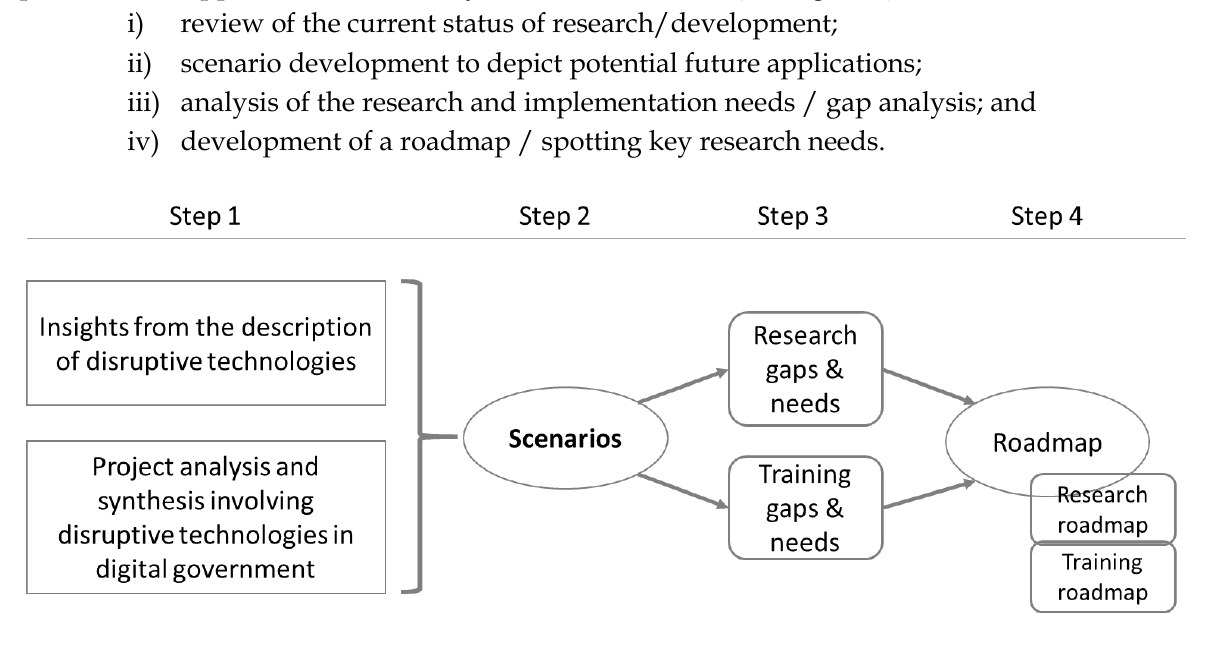
Figure 1: Research design to investigate research and training needs on Government 3.0 The first step was conducted using literature reviews on the use of disruptive technologies in Government 3.0 (1039 articles, see (Gov 3.0, 2018b)) combined with analysis of existing projects (a total of 281 projects, see (Gov 3.0, 2019)). The findings of the status-quo analysis built the foundations for developing future